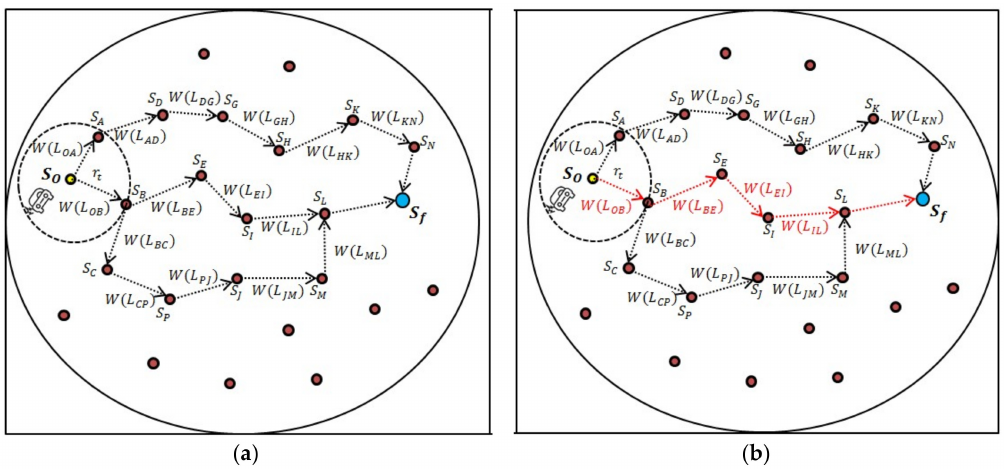
Figure 4. Multi-hop weighted path within a cluster: ( a ) directed graph with weights for each link between origin node ( S o ) and destination node ( S f ) ; ( b ) path with minimum weights selected from S o to S f